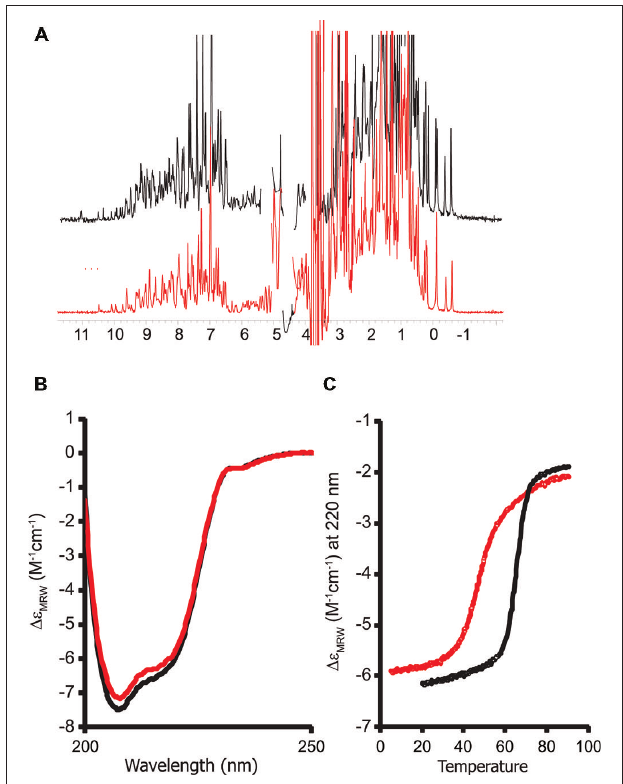
FIGURE 4 | Probing the structure of the G137V mutant and comparison with the wild-type protein . The spectra of wild-type human frataxin are plotted in black, those of the mutant in red. (A) Comparison of the one-dimensional 1 H nuclear magnetic resonance (NMR) spectra recorded in H 2 O/D 2 O (90/10 v/v) at pH 8. (B) Far-UV circular dichroism (CD) spectra. (C) Thermal denaturation scans monitored by far-UV CD. The spectra were recorded at 220 nm and pH 8. CD intensities are presented as the CD absorption coefficient calculated on a mean residue weight basis ( ∆ ε MRW ).